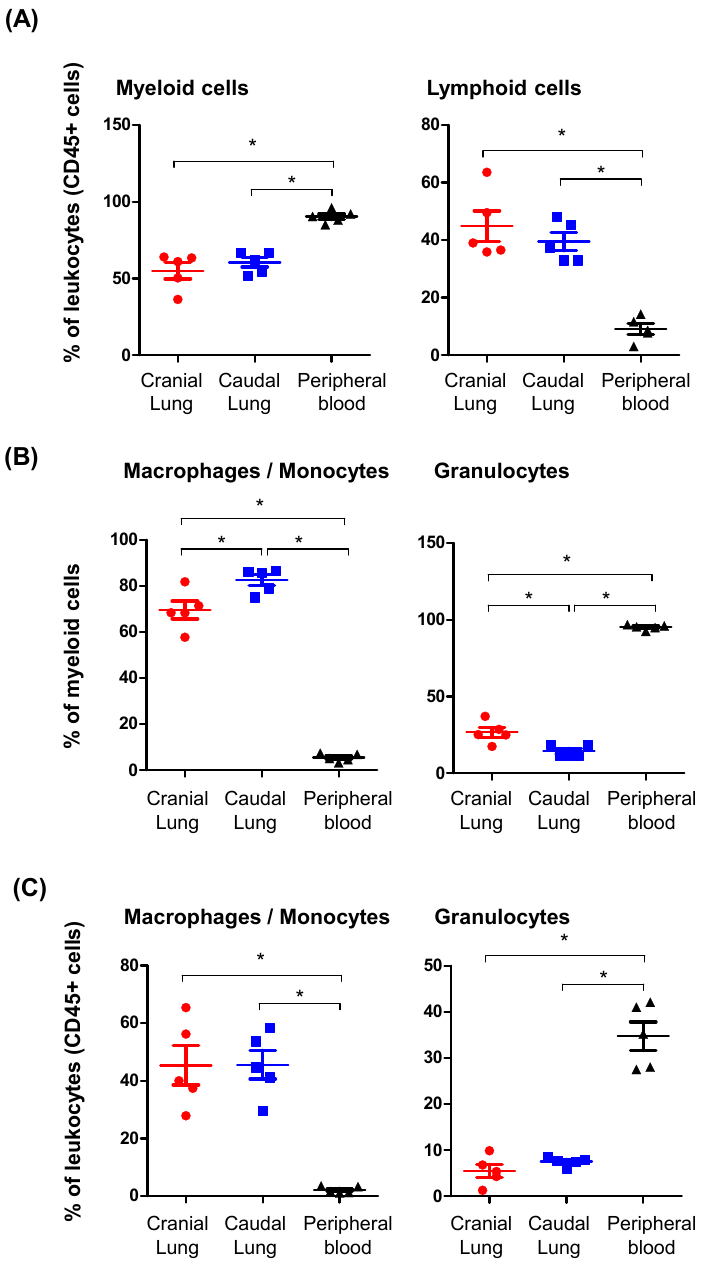
Figure 2. Leukocyte populations in cranial and caudal lung tissue and the peripheral blood of dromedary camels. Camel lung and blood leukocytes were labeled with antibodies to CD45, CD172a, and CD14, and labeled cells were analyzed by flow cytometry. ( A ) The percentage of myeloid (CD172a-positive cells) and lymphoid (CD172a-negative cells) cells within total leukocytes (CD45-positive cells) were calculated and presented graphically for cranial and caudal lung tissues and blood leukocytes. ( B ) Lung macrophages and blood monocytes were differentiated from granu- locytes based on the differential expression of CD14. The percentages of macrophages/monocytes and granulocytes within lung and blood myeloid cells were calculated and presented graphically for cranial and caudal lung tissue and blood leukocytes. ( C ) The percentages of macrophages/monocytes and granulocytes within total lung and blood leukocytes were calculated and presented graphically for cranial and caudal lung tissue and peripheral blood. * indicates a significant difference between the groups ( p <